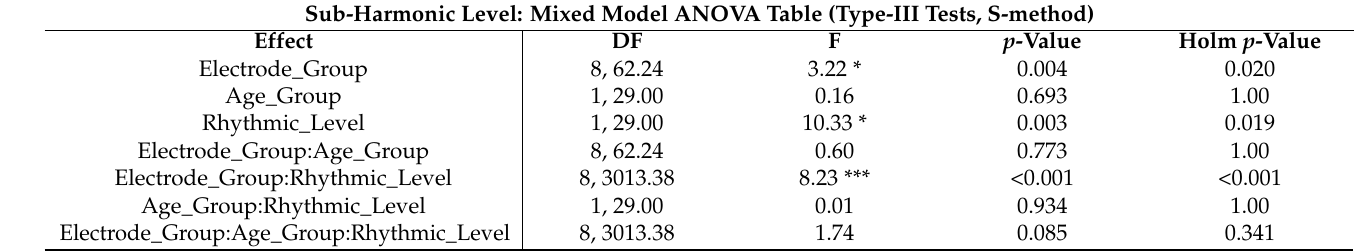
Table 4. Sub-harmonic level—ANOVA Table. For the subharmonic level, a linear-mixed effect model returned a significant two-way interaction between the electrode group*rhythmic level fixed effects on phase-locking values (PLV) to music.